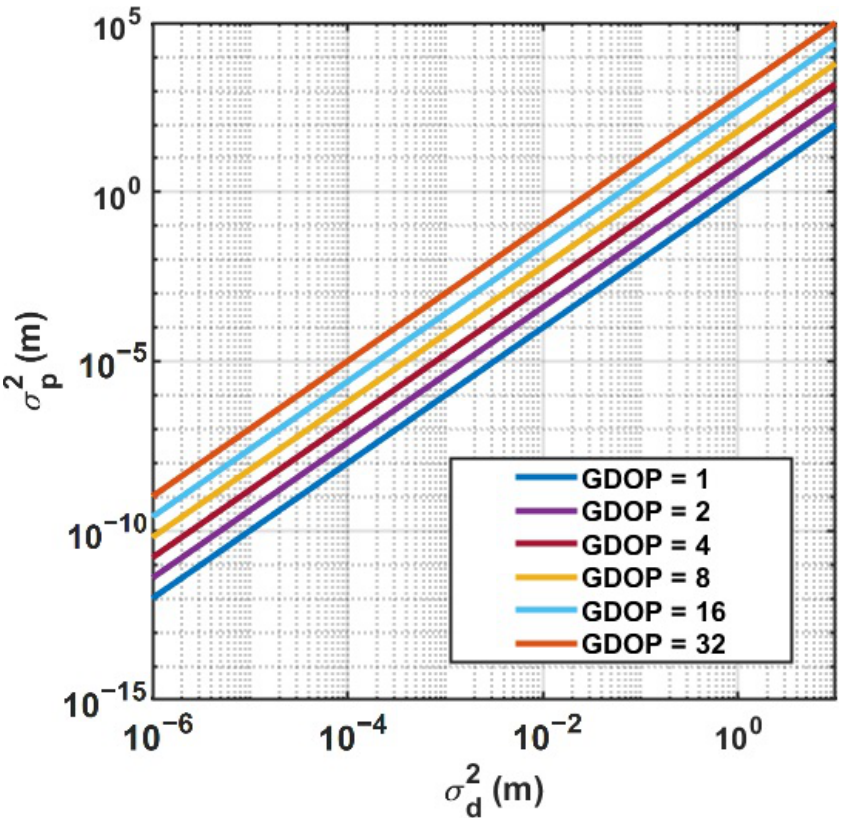
Figure 7. The 3D position CRLB vs. ranging precision for several GDoP values. These curves can help inform system design decisions such as antenna placement or required ranging precision. In general, a GDoP of 1 is considered “ideal”, between 2 and 10 is considered “good”, and anything beyond 20 is considered